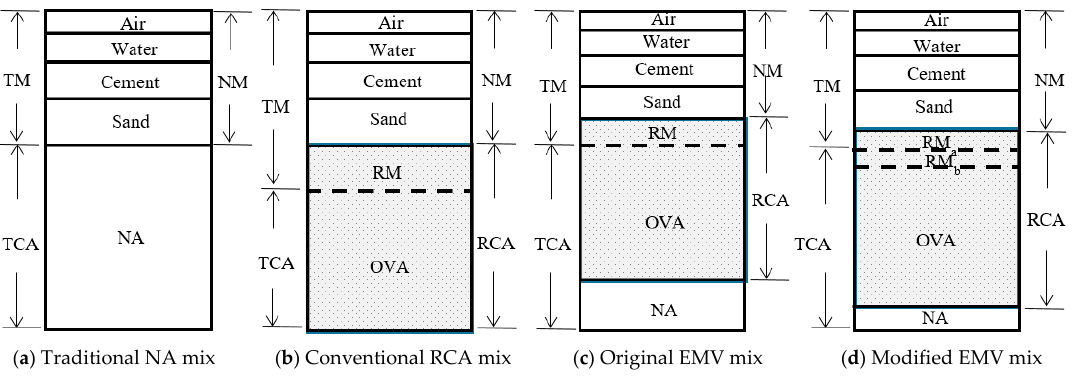
Figure 1. Schematic diagrams of different mix designs; TM: Total Mortar; TCA: Total Coarse Aggregate; NA: Natural Aggregate; NM: New Mortar; RM: Residual Mortar; OVA: Original Virgin Aggregate; RCA: Recycled Concrete Aggregate.